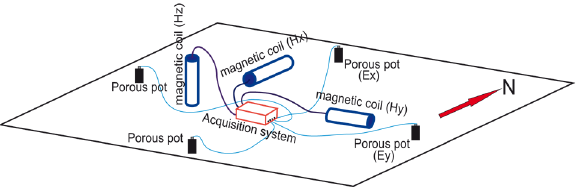
Figure 3. MT field layout. Three magnetic coils are placed in three mutually perpendicular directions (two horizontal and one vertical) to measure the natural magnetic fields. Two pairs of porous pots are put in mutually perpendicular directions (N-S and E-W) to measure the electric field induced by the magnetic field.